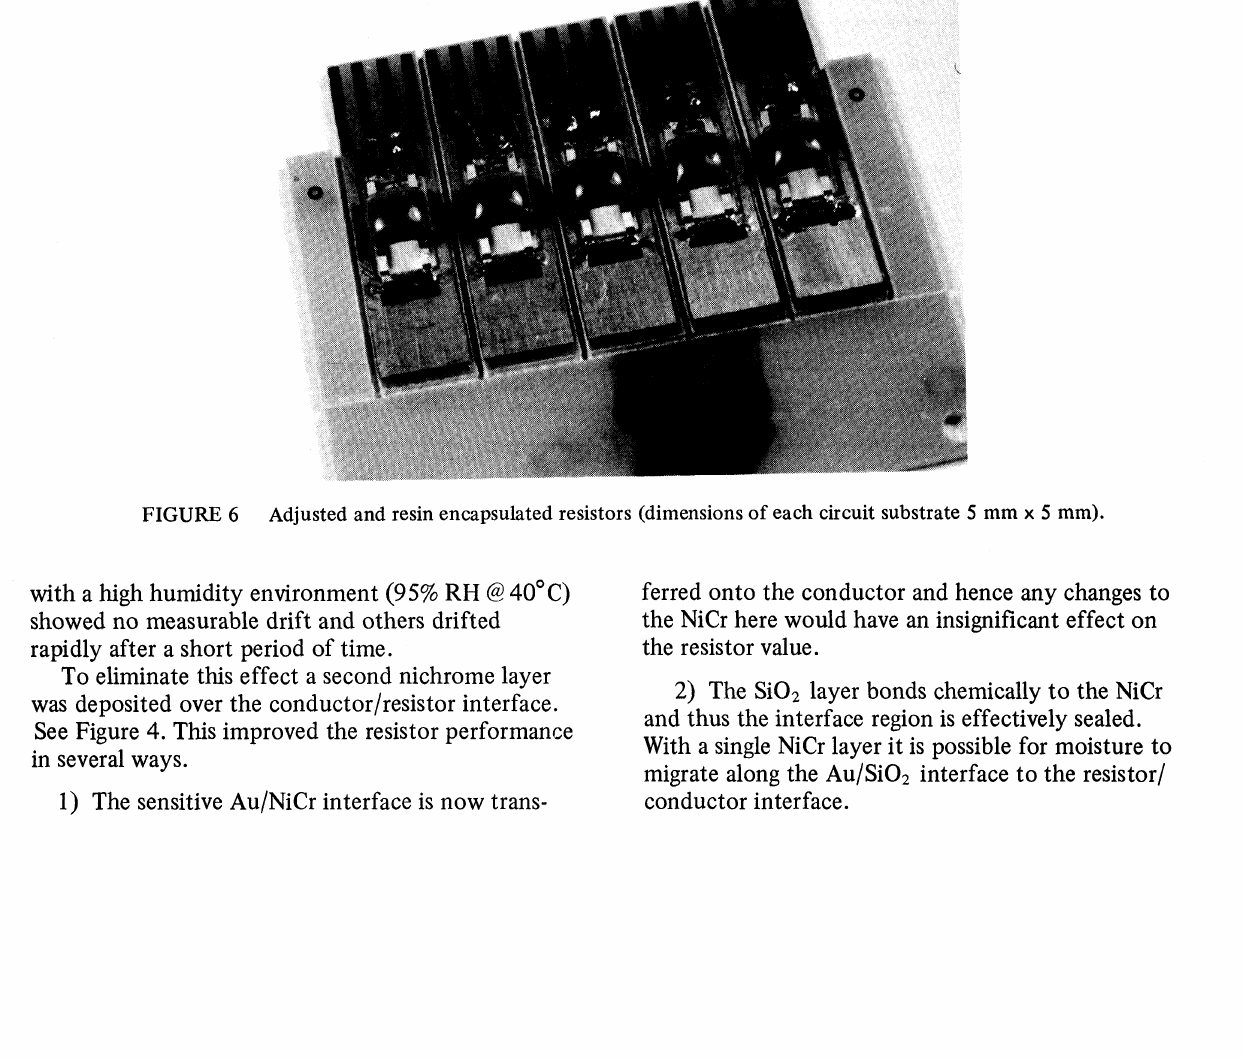
FIGURE Adjusted resistors (dimensions of each circuit substrate 5 mm x 5 mm).